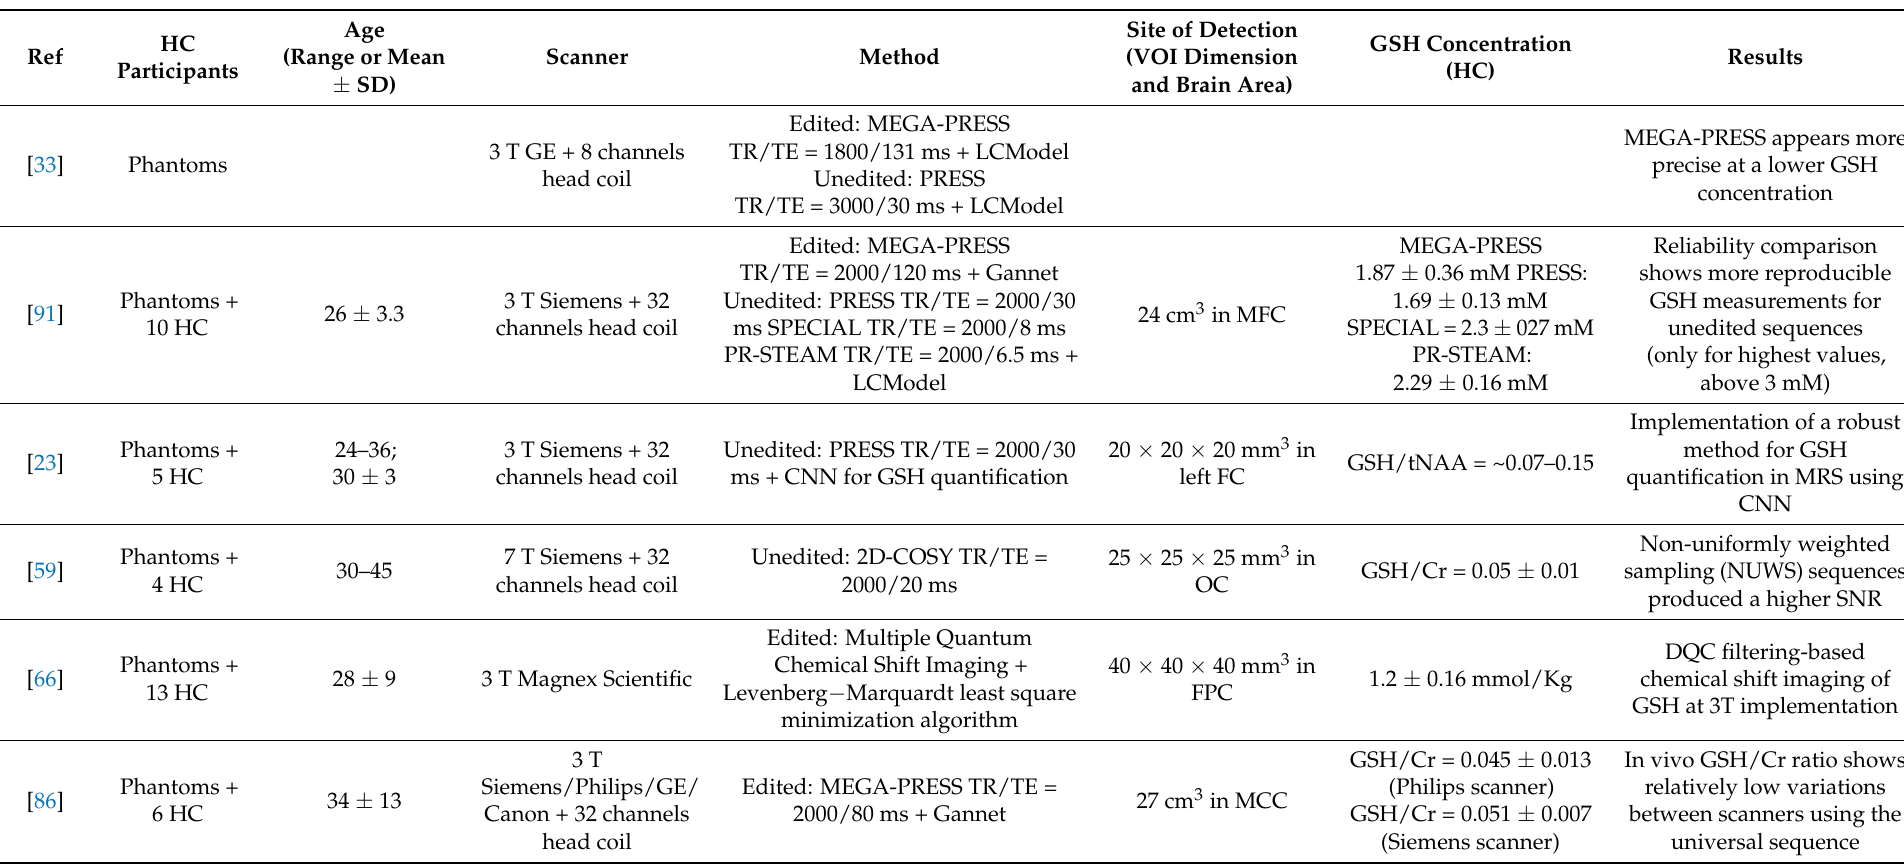
Table 1. Number of healthy control subjects, the corresponding age, and GSH concentration measured in the brain areas, type of scanner, method, site of voxels for the GSH measurements, and the results reported in the